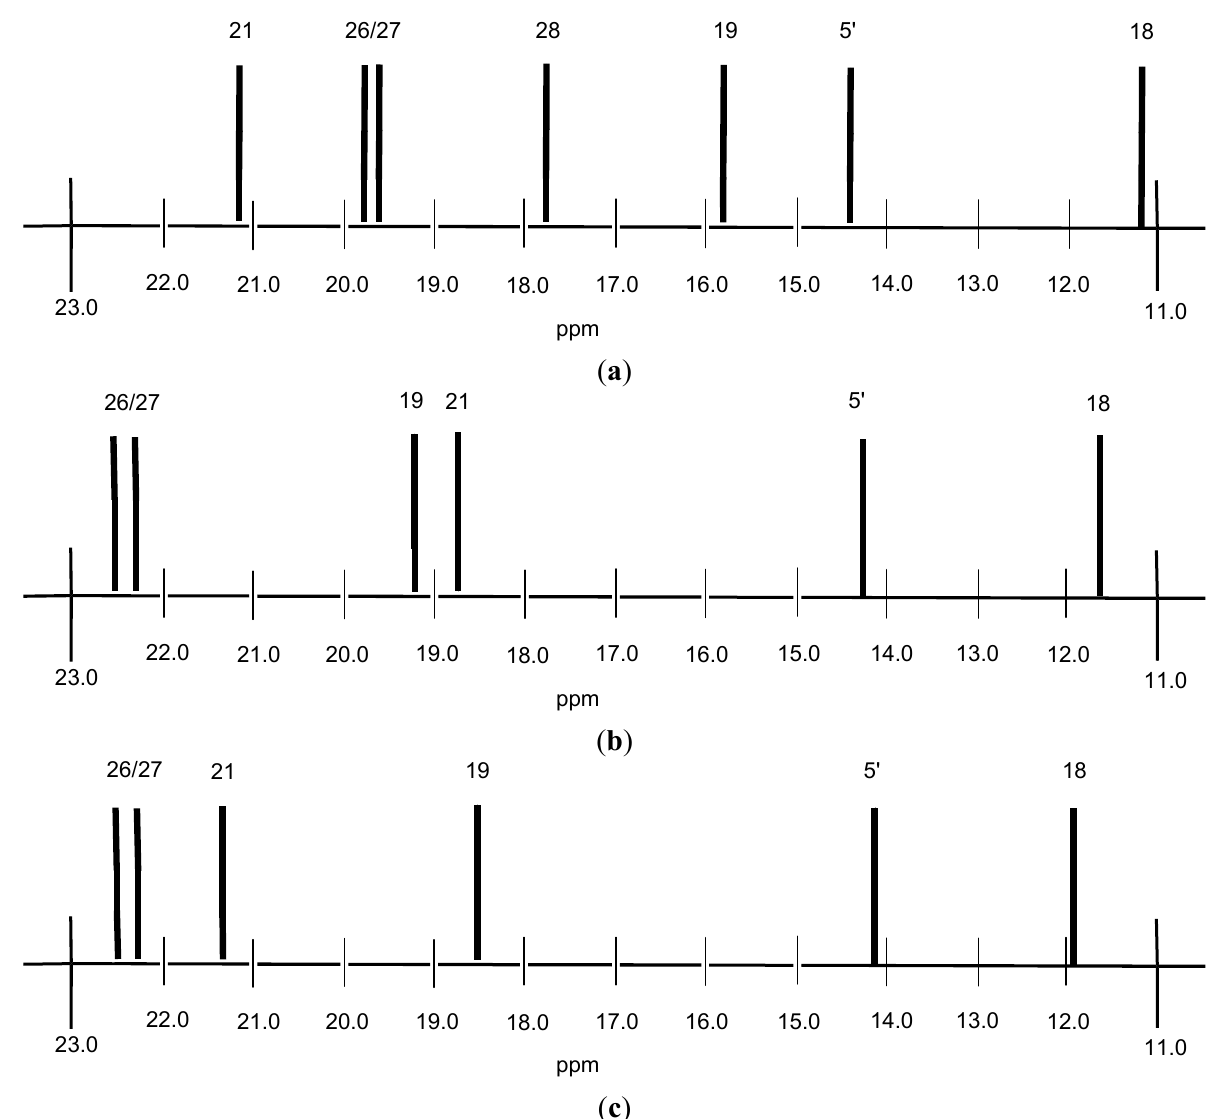
Figure 4. Analytical differences of CH corresponding 13 C-NMR